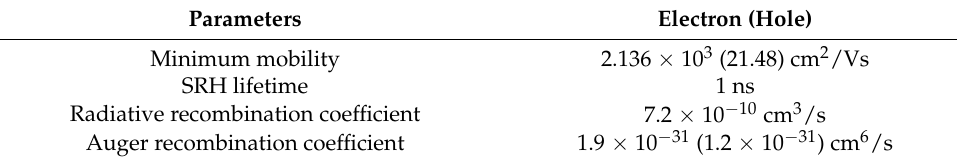
Table 1. Key material